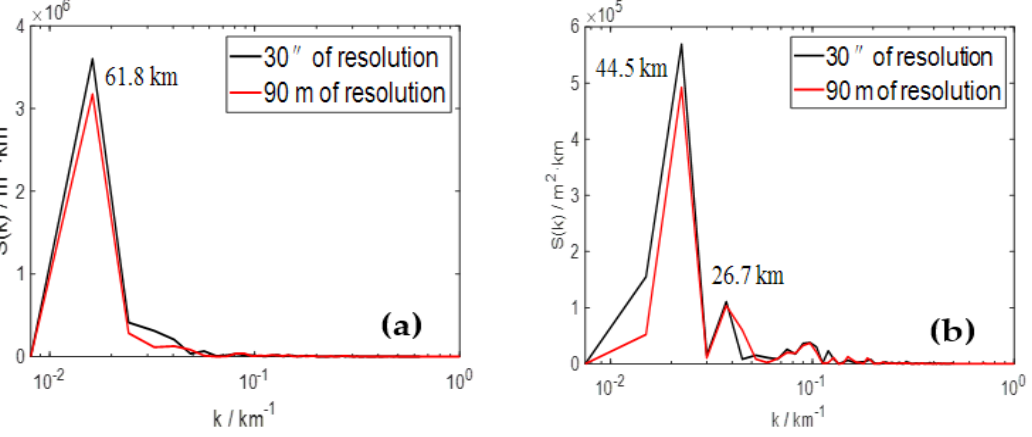
Figure 2. The weighted-average terrain height variance spectra ( a ) in zonal direction and ( b ) in meridional direction. Black curve and red curve correspond to 30 ″ resolution and 90 m resolution, respectively.